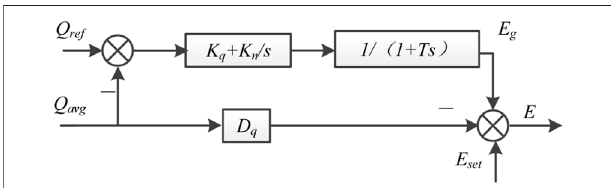
FIGURE 3 | Reactive power control block diagram.